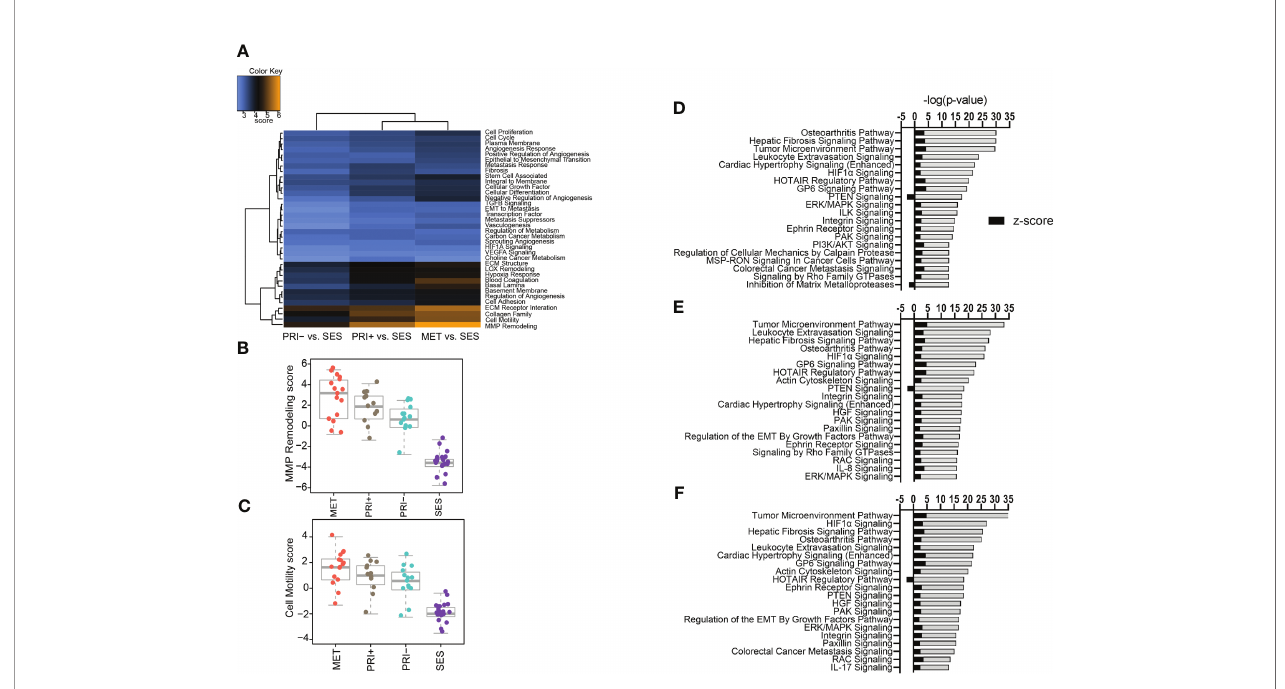
FIGURE 2 | Pathway analyses of tumors vs. SES. (A) Heatmap of global signi fi cance scores of cancer progression gene annotations generated using nSolver Advanced Analysis software 2.0 (orange denotes gene sets whose genes exhibit extensive differential expression with the covariate (SES), blue denotes less differential expression). (B, C) Boxplots showing pathway scores (y-axis; fi t using the fi rst principal component of each gene set ’ s data) for two of the top differentially expressed cancer pathways speci fi ed in the heatmap. (D – F) Top 20 activated and inhibited canonical pathways (refer to Supplementary Data File 3 ) for (D) MET vs. SES, (E) PRI+ vs. SES, and (F) PRI- vs. SES showing signi fi cance level (-log (p-value)) along the x-axis and absolute activation z-score (<-2, >2) along the